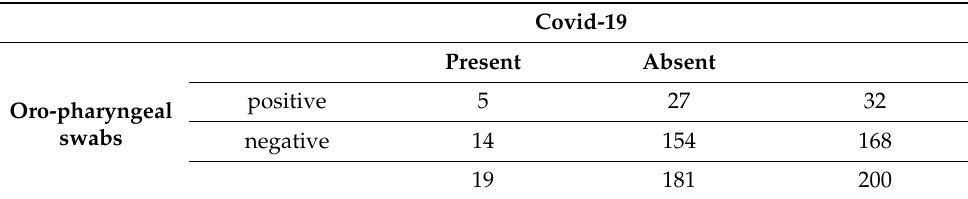
Table A4. Prevalence of COVID-19 equal to 9.5% with sensibility equal 27% and specificity equal 84.9%.